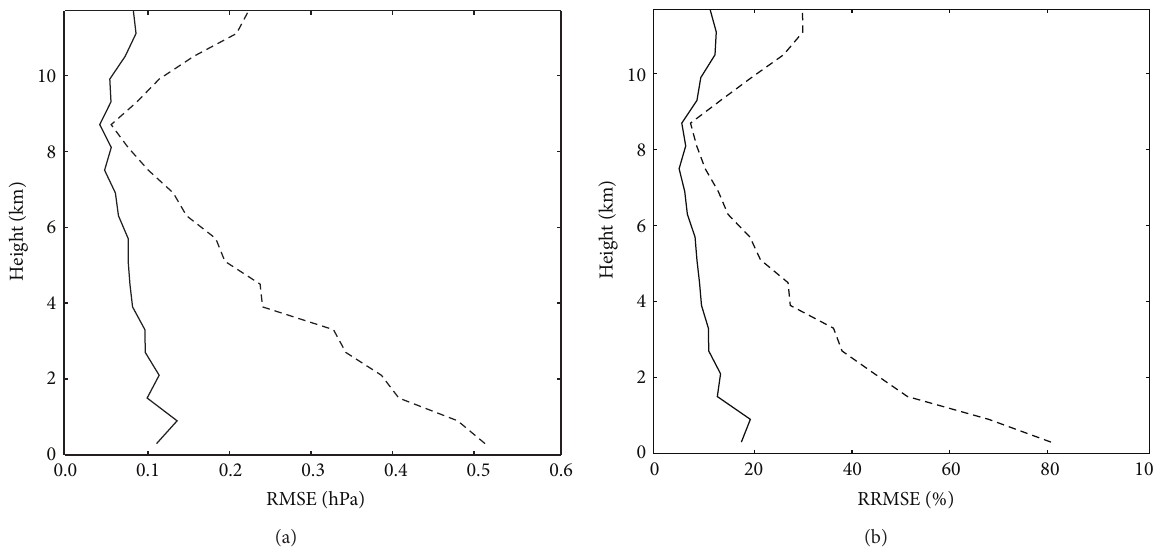
Figure 5: As in Figure 3 (top row) but for 𝑝 3